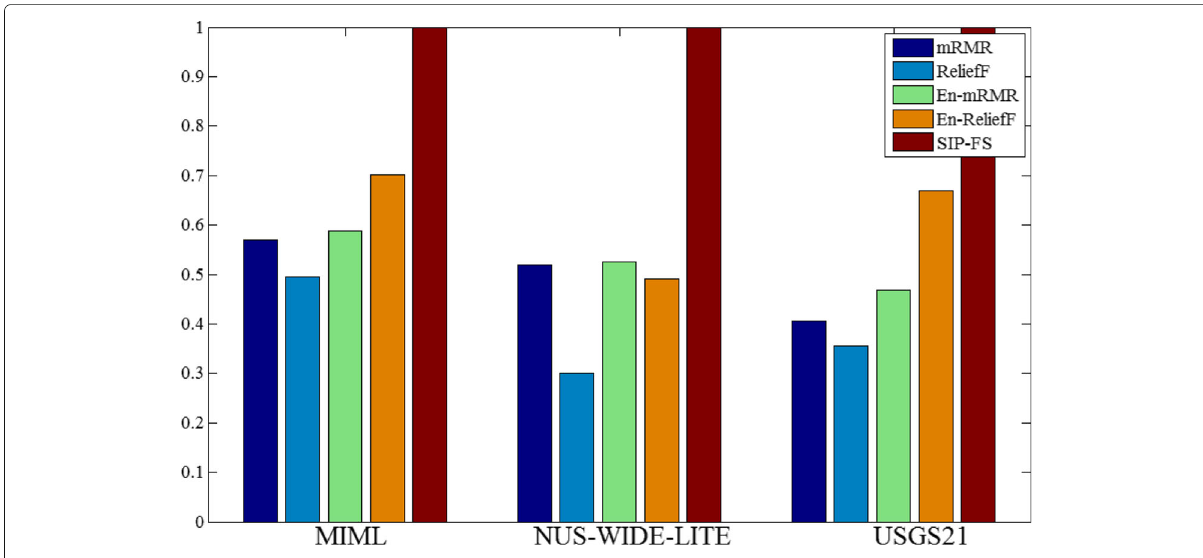
Fig. 10 SPT comparisons for three datasets